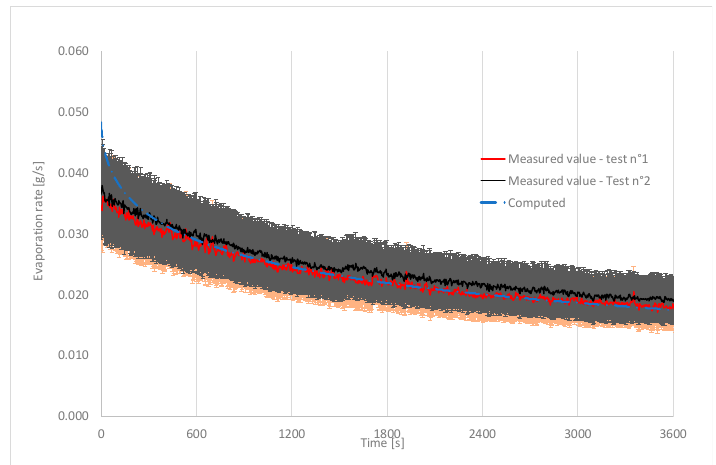
Figure 8. Evolution of the evaporation rate for test no. 1 and test no. 2 (repeatability).